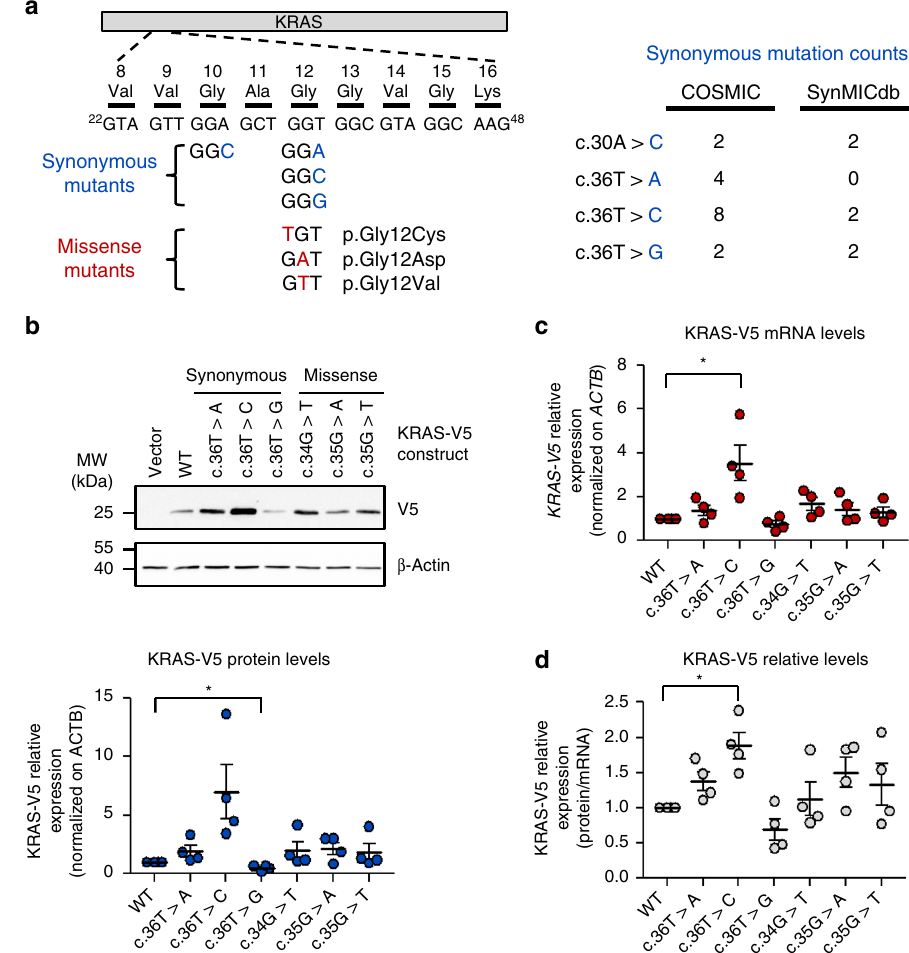
Fig. 7 Synonymous mutations in KRAS codon 12 impact its expression. a Left: Schematic representation of the cancer-derived KRAS mutations analyzed in this study. Right: KRAS synonymous mutation counts in COSMIC database v82 and in SynMICdb. b HEK293 cells were transfected with the indicated KRAS-V5 mutants. Top: Expression of the constructs was evaluated by Western blotting using V5 and ACTB antibodies. A representative experiment is shown. Bottom: Quanti fi cation of the Western blot signals obtained as in top panel. V5 signals were normalized to ACTB signals. c Measurement of KRAS- V5 mRNA levels in the samples described in b after RNA isolation and RT-qPCR. V5 signals were normalized to ACTB signals. d KRAS-V5 codon 12 mutants relative expression was obtained after normalization of the protein signals for each mutant on their respective mRNA levels. b – d Mean of four independent experiments is presented. Error bars: SEM. * p ≤ 0.05 ( t